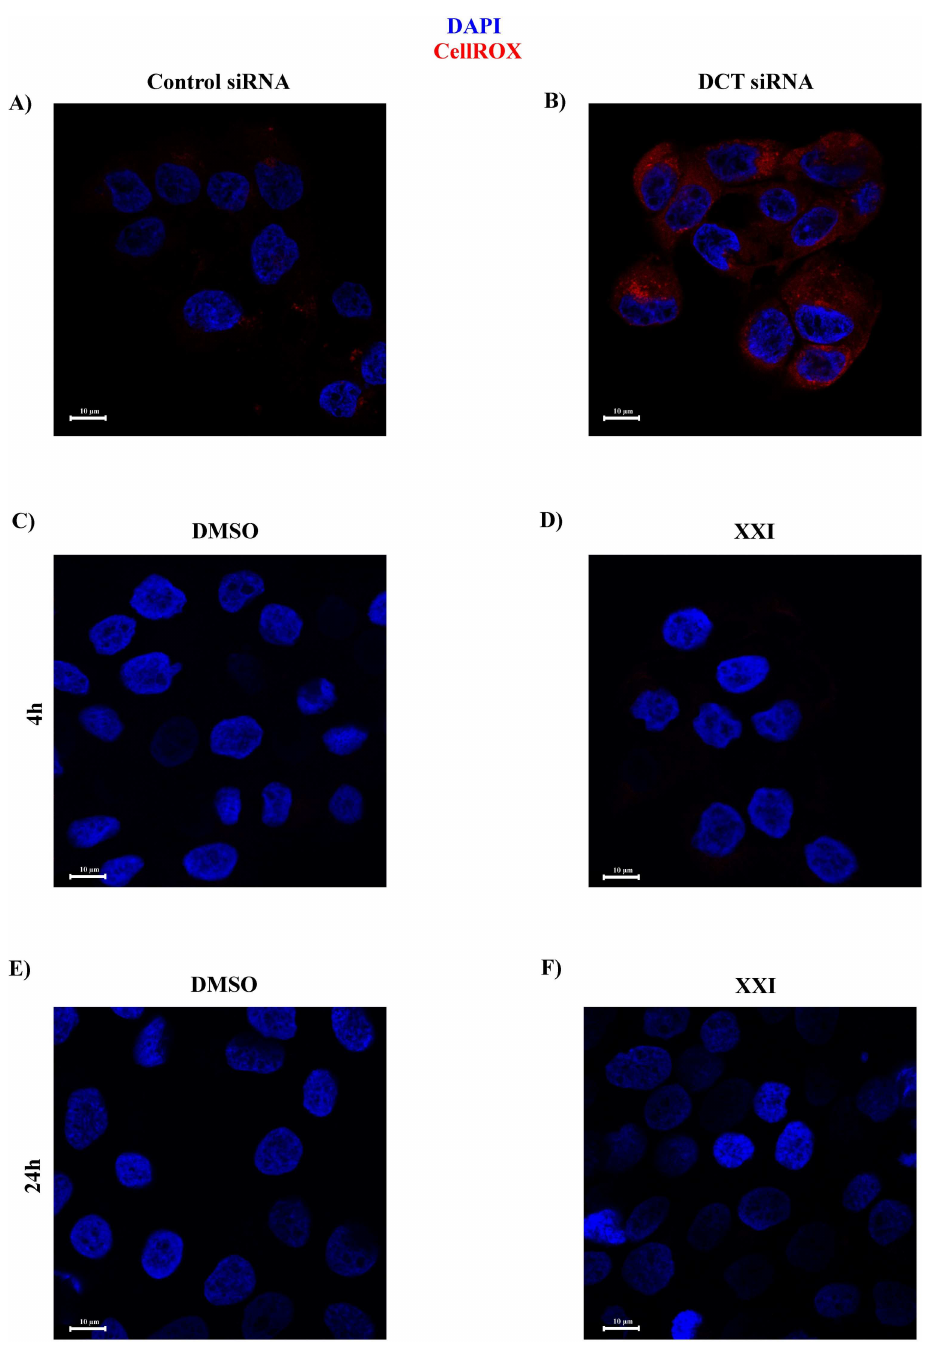
Fig 6. Depletion of DCT causesincreased ROS production, whereas XXI treatment does not. On the day of the knockdown, control and DCT knockdown cells were treated with CellROXdeep red reagent to detect oxidativestress levels under each treatment. The cells were fixed and visualizedby confocal microscopy. Cell nuclei were stainedwith DAPI (blue). OxidizedCellROX signalwas detected in red. (A) ControlHaCaTs. (B) DCT knockdown HaCaTs. (C-F) HaCaTs were treated with XXI or DMSO for 4h or 24h and CellROXreagent was added to detect